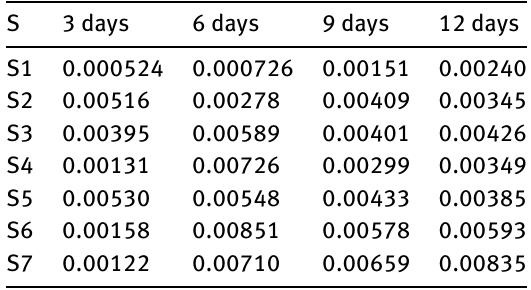
Table 4a: Corrosion rate